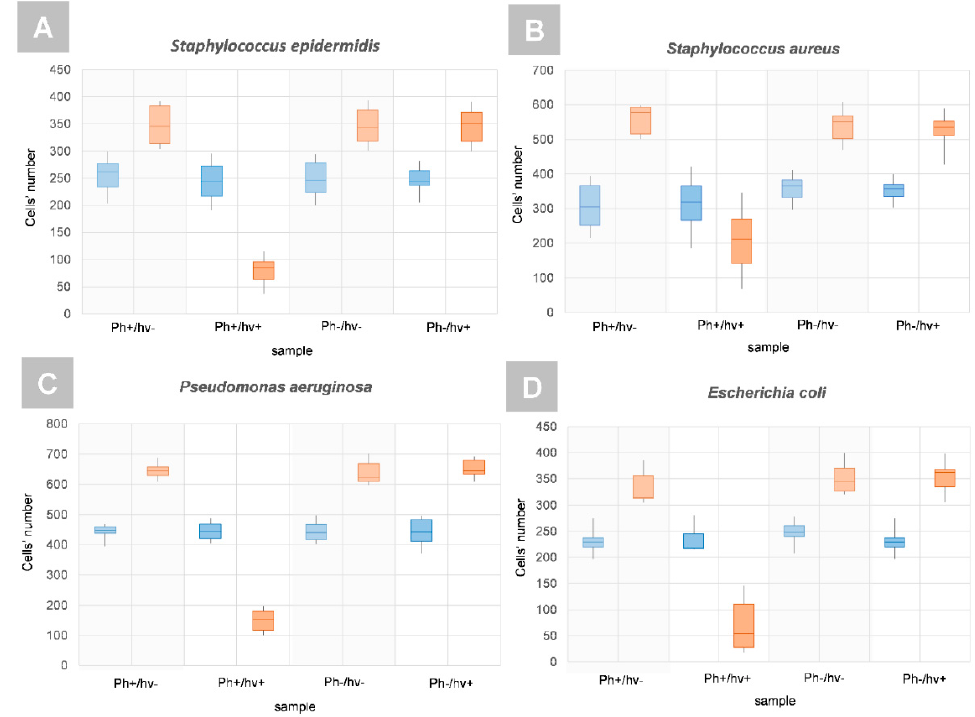
Figure 10. Representative boxplots of the number of single cells of Gram-positive: ( A ) S. epidermidis and ( B ) S. aureus and Gram-negative bacteria species: ( C ) P. aeruginosa and ( D ) E. coli that were cultivated on different surfaces (Ph+/h ν − : PS-doped silica coating not illuminated, Ph+/h ν +: PS- doped silica coating illuminated, Ph − /h ν -: silica coating not illuminated, and Ph − /h ν +: silica coating illuminated). The red boxes represent the results before PS-photoexcitation and the blue boxes 24 h after PS-photoexcitation (aPDT treatment).